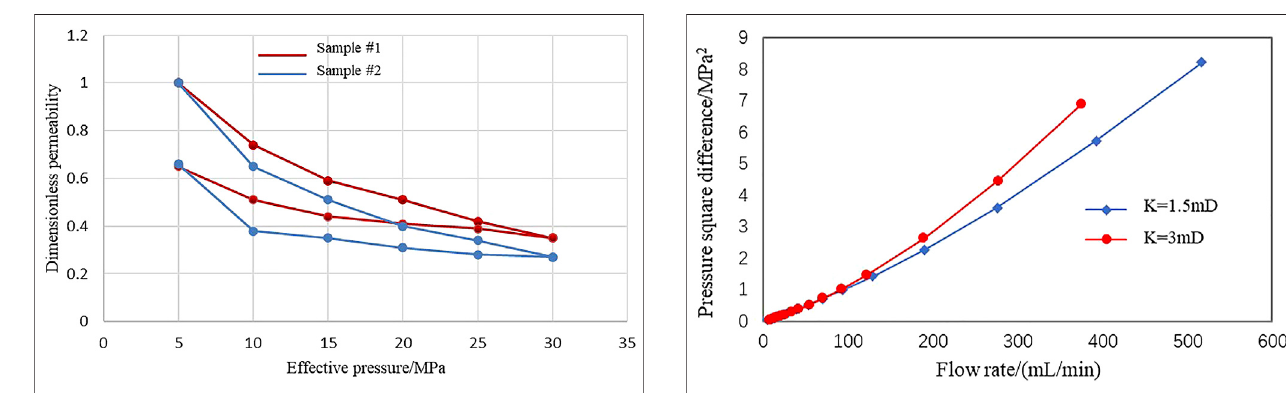
FIGURE 2 | Non-Darcy feature of the fracture-pore type reservoir rock.